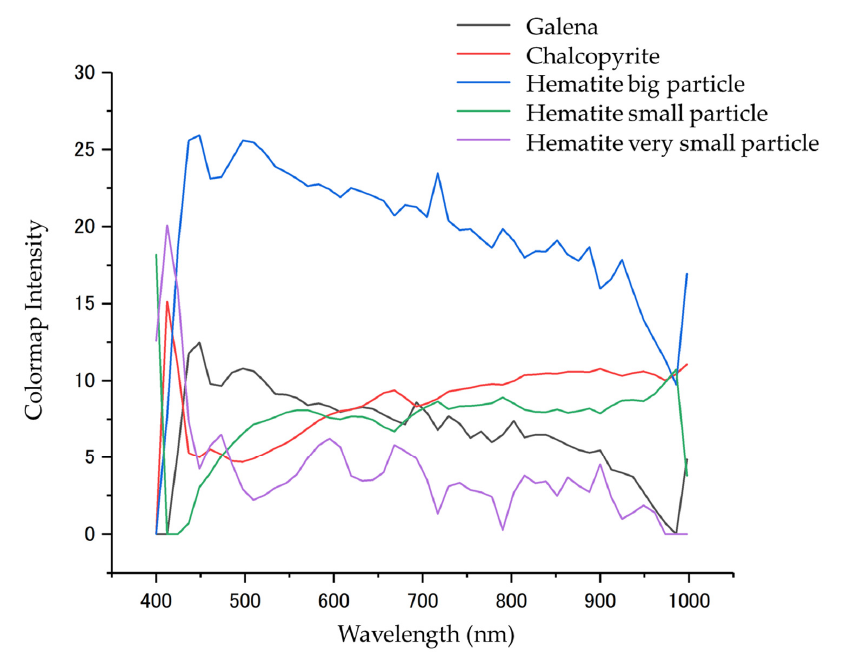
Figure 19. Results of the Grad-CAM analysis for the deep learning results.